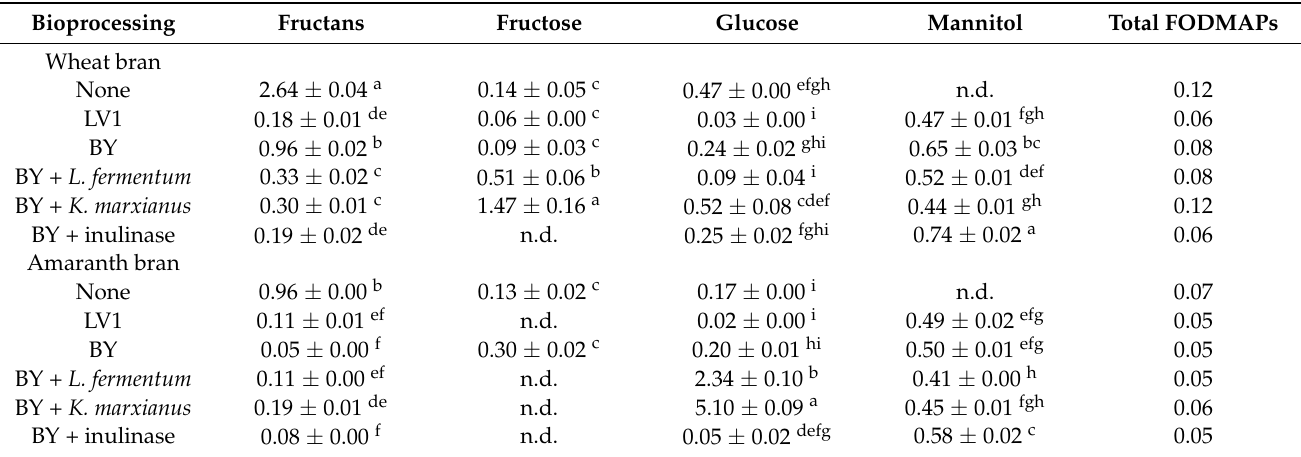
Table 1. FODMAPs and glucose content in wheat and amaranth bran (% dry matter) and estimated total FODMAPs content in a serving of baked snacks (g/30